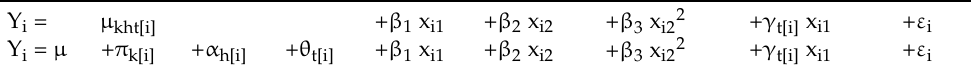
Table 6. Proposed covariance analysis model to predict the toxicities as a function of the baseline AEC.